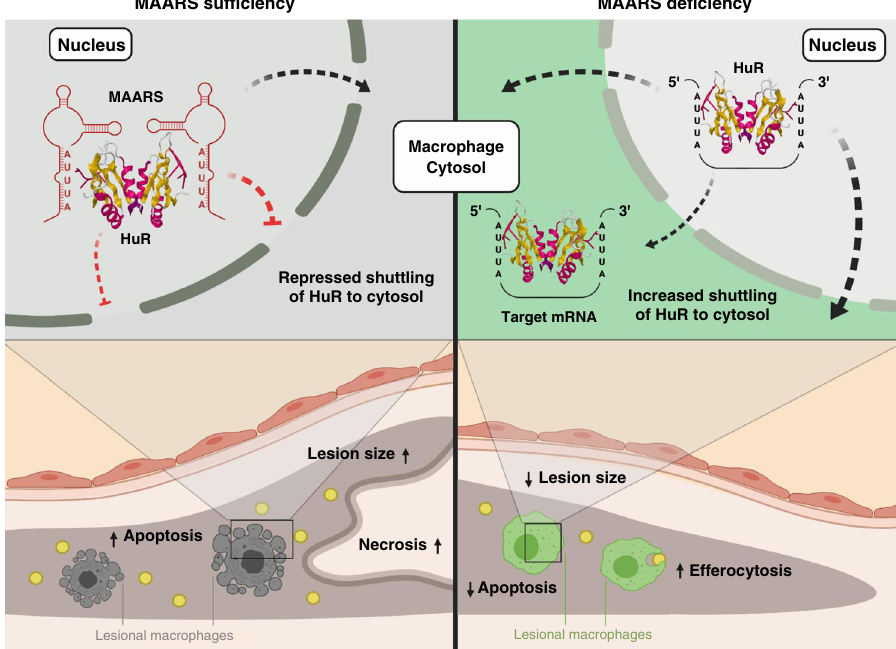
Fig. 7 Proposed mechanism for MAARS regulation of HuR and effects on macrophages apoptosis, efferocytosis, and atherosclerosis. MAARS interacts with HuR (Protein Data Bank structure 6GC5) by tethering it in the macrophage nucleus, preventing its shuttling to the cytosol and interfering with its RNA-stabilizing function. MAARS de fi ciency induces HuR shuttling in the cytosol, decreasing macrophage apoptosis and increasing macrophage efferocytosis. Consequently, plaque necrosis and atherosclerosis progression is reduced. Created with